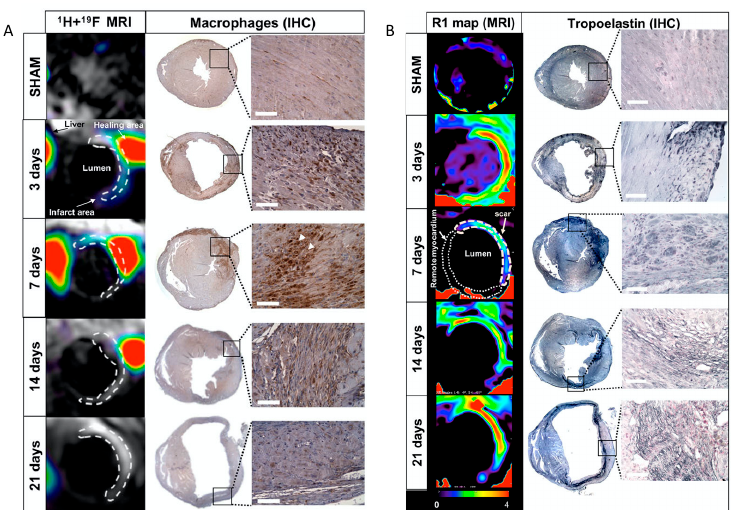
Figure 17. ( A ): Assessment of inflammatory response after myocardial infarction in mice at 3T magnetic resonance imaging (MRI) using 19F perfluorocarbons. Representative short-axis views of co-registered 1H + 19F images (left column; N = 8 MI animals / time-point; N = 6 SHAM-operated animals / time-point) and macrophage immunohistochemistry (IHC; macrophages identified as MAC-3 positive, brown; N = 4 MI animals / time-point; N = 3SHAM-operatedanimals / time-point)fromtheheartat3, 7, 14, and21daysafterMI. ( B ): In vivo imaging of extracellular matrix remodelling after myocardial infarction with a gadolinium-based elastin / tropoelastin-specificcontrastagentRepresentativeshort-axisimagesofrelaxationrate(R1,leftcolumns) maps and tropoelastin immunohistochemistry (IHC; right columns) of the hearts sections at 7, 14, and 21 days post-myocardial infarction (MI) at 3T magnetic resonance imaging (MRI). Tropoelastin fibres were identified as black fine fibre network. Reproduced with permission from Ramos et al., 2018